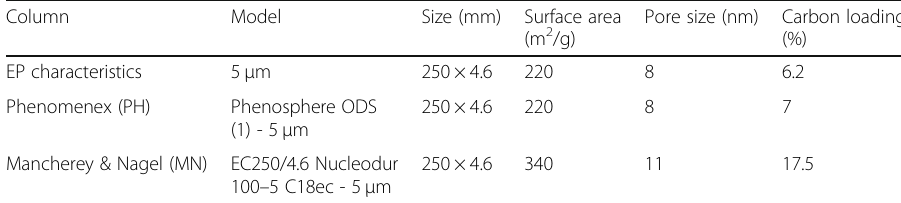
Table 2 Characteristics of the tested stationary phases Column Model Size (mm) Surface area